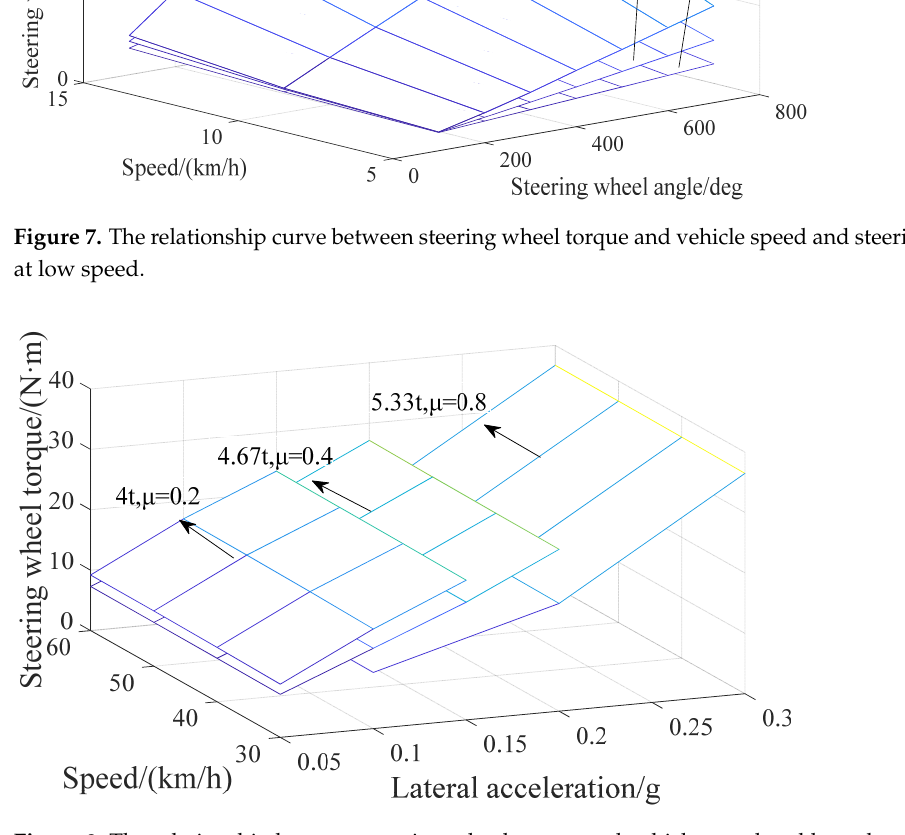
Figure 8. The relationship between steering wheel torque and vehicle speed and lateral acceleration at medium and high speed.